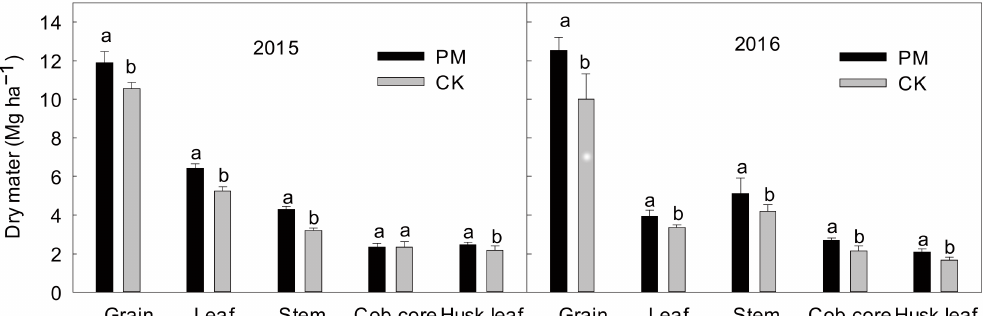
Figure 1. The differences in spring maize dry matter biomass between the PM and M treatments in 2015 and 2016, respectively. The error bars represent the standard error of the mean ( n = 3). Means followed by different letters are significantly ( p < 0.05) different between film mulched and non-mulched. PM, maize mulched with plastic film; CK, maize without plastic